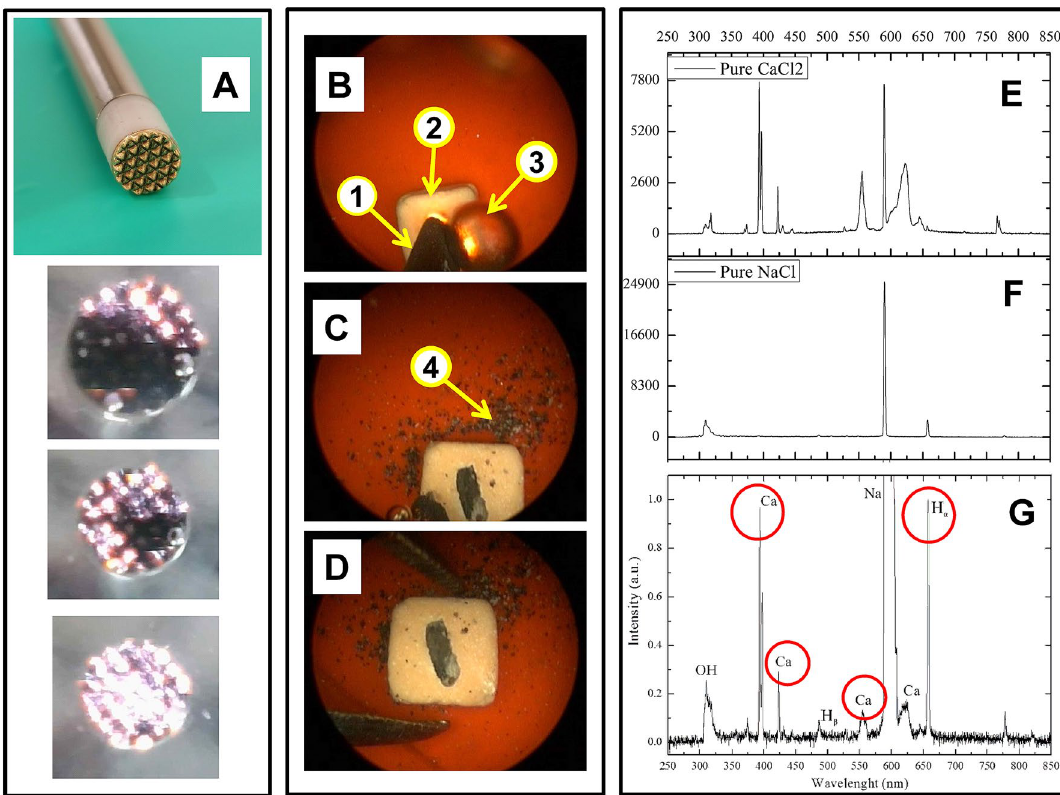
Figure 3. The distal part of the probe for plasmakinetic lithotripsy ( A ): active and passive electrodes. The images of plasma on the active electrode of the probe at the threshold of ignition, intermediate and in the full operating mode are shown ( A ). Operating field views of the stone destruction: initial ( B ), intermediate ( C ), and final stages ( D ). The active electrode ( B1 ), a dummy stone ( B2 ), and a bubble of hydrogen ( B3 ) are shown. The effect of thermic shock wave action on the sample ( C4 ). Spectra of pure CaCl 2 ( E ) and NaCl ( F ), and the spectrum of solution after stone treatment by plasma ( G ).